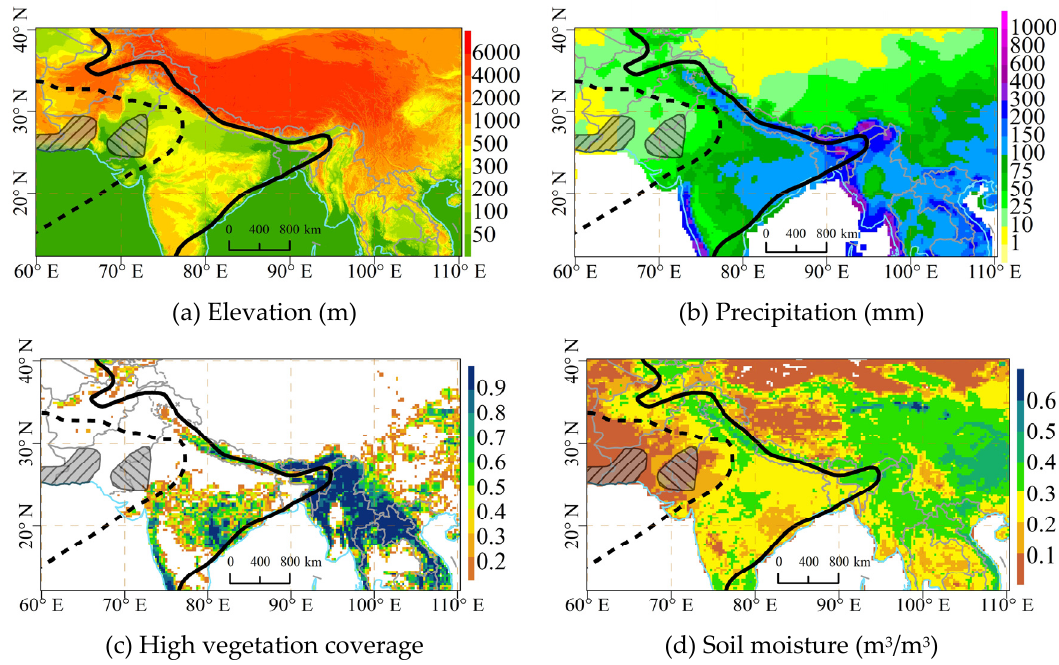
Figure 8. The spatial distribution of climatic factors near the southwest border of China during 2008–2019.